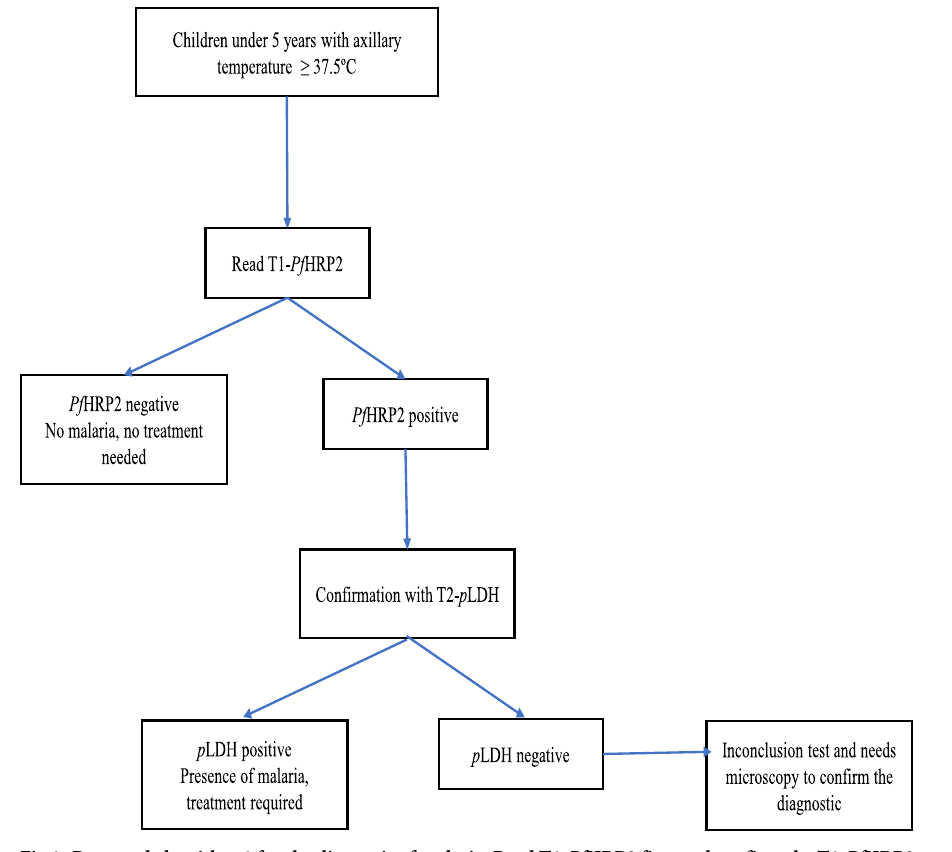
Fig 1. Proposed algorithm 1 for the diagnosis of malaria: Read T1- Pf HRP2 first and confirm the T1- Pf HRP2 positive line results with T2- p LDH line.